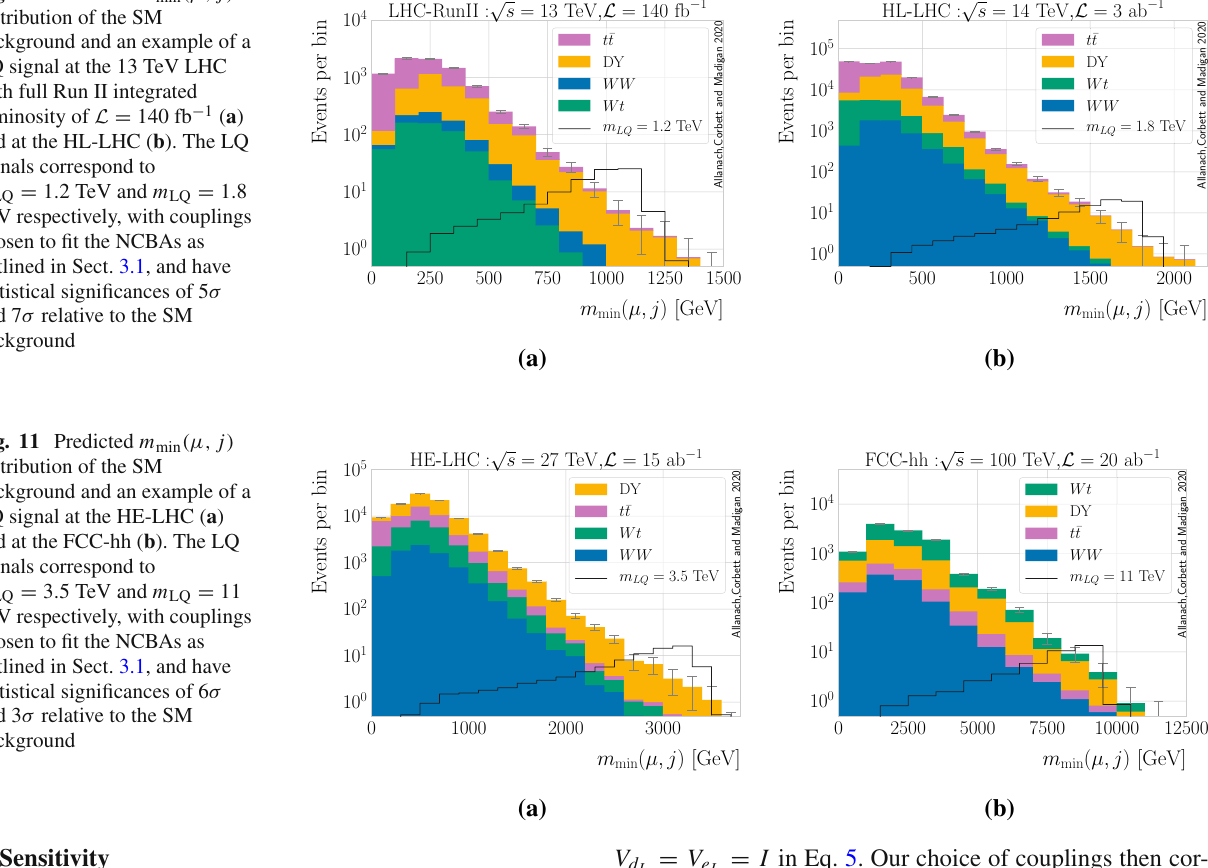
Fig. 10 Predicted m min (μ, j ) distribution of the SM background and an example of a LQ signal at the 13 TeV LHC with full Run II integrated luminosity of L = 140 fb − 1 ( a ) and at the HL-LHC ( b ). The LQ signals correspond to m LQ = 1 . 2 TeV and m LQ = 1 . 8 TeV respectively, with couplings chosen to fit the NCBAs as outlined in Sect. 3.1, and have statistical significances of 5 σ and 7 σ relative to the SM